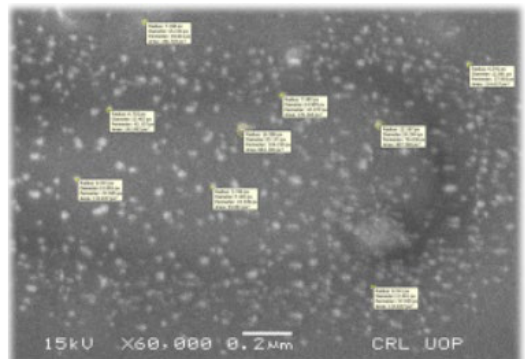
Fig. 4. Photomicrograph of Digimizer, mean particle size and area along with its intensity and length of copper acetate nanoparticles at resolution of 15 kv x 60,000